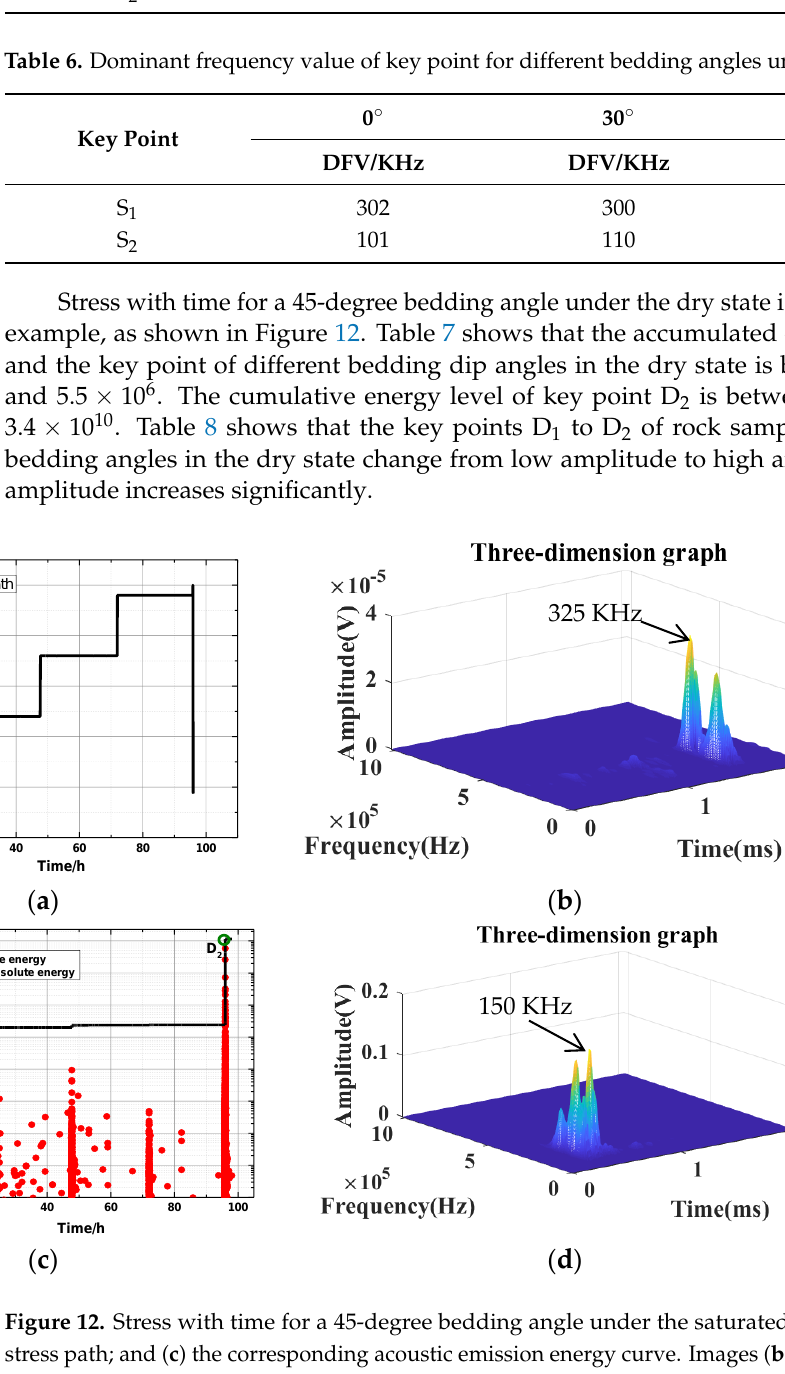
Table 8. Dominant frequency values of key point for different bedding angles under dry state. Key Point